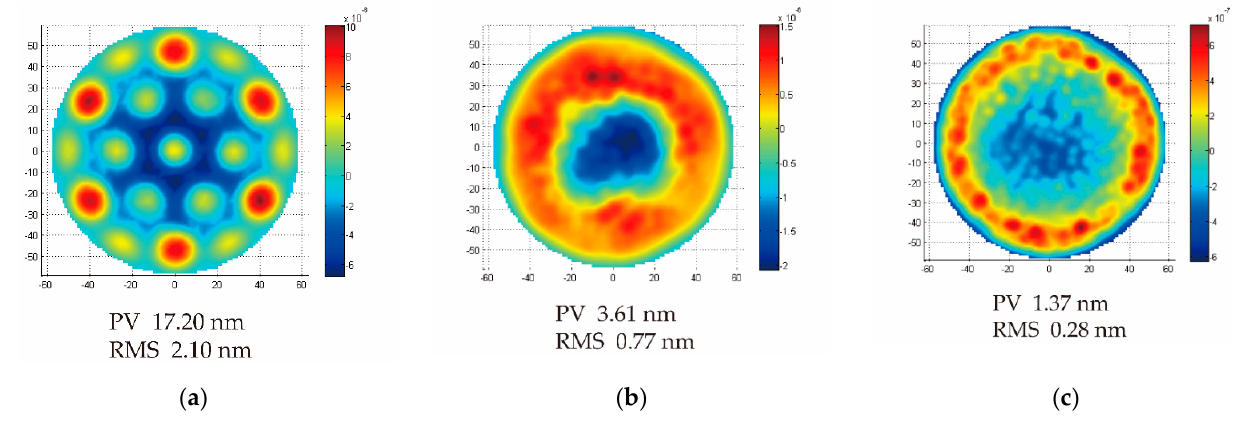
Figure 14. Surface shape fitting nephograms after the post-polishing analysis: ( a ) honeycomb mirror; ( b ) 2.5D-Voronoi mirror; and ( c ) 3D-Voronoi mirror.